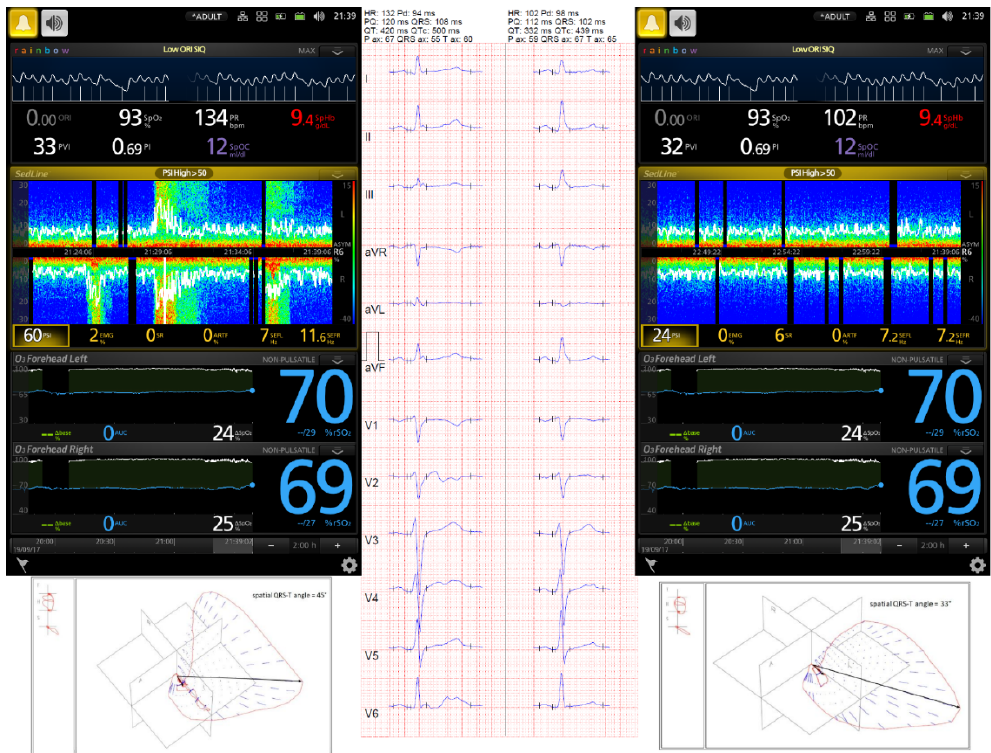
Figure 3. A 54-year-old male admitted to the intensive care unit (ICU) for severe TBI. His Glasgow Coma Score was 4. Computed tomography (CT) showed cerebral edema with reduced size of both lateral ventricles. Patient was sedated with continuous infusion of propofol and fentanyl, and hyperosmotic therapy with 15% mannitol was administered. According to the local ICU protocol, non-invasive monitoring including near-infrared spectroscopy (NIRS) and frontopolar electroencephalography (EEG) was applied. Frontopolar EEG and seizures were monitored by the Masimo Root SEDLine device. Despite deep sedation (Patient State Index was 7), the DSA image showed upward y-axis arcs in warmer colors, and the recorded EEG confirmed a polyspike and slow wave. Continuous thiopental infusion at the dose of 50 µ g · kg − 1 · min − 1 was used to suppress ESz, after which a serial 12-lead ECG showed a notably reduced QTc interval. The patient was discharged from the ICU 14 days after trauma.